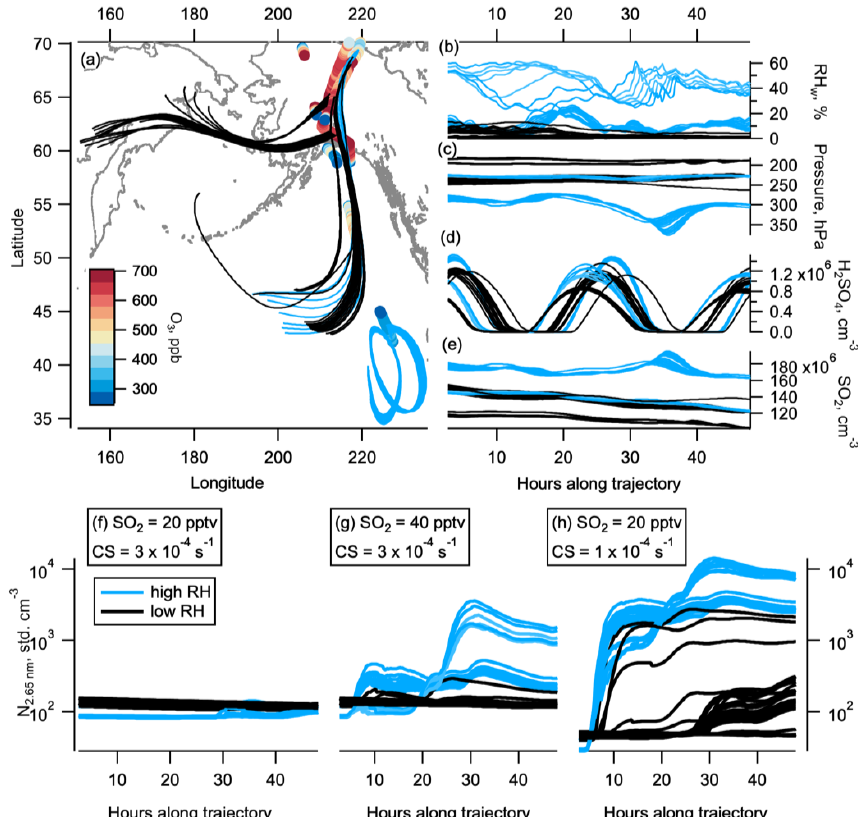
Figure 7. Box modelling and back trajectories. The 48h back trajectories from selected observations in the NH LMS in May. Geographical location of back trajectories (lines) and observations (circles, coloured by ozone level) are shown in panel (a) . Black lines are trajectories where the relative humidity (RH w ) was mostly below 10%, indicating stratospheric conditions. Light blue lines are trajectories where the RH w was often above 10%, indicating tropospheric conditions. RH w , pressure, sulfuric acid, and SO 2 (from initial 20pptv SO 2 ) are shown in panels (b) , (c) , (d) , and (e) respectively. Modelled number concentration of 2.7nm particles on the high-RH w (blue) and low-RH w (black) trajectories are shown for the initial 20pptv SO 2 and starting condensation sink (CS) of 3 × 10 − 4 s − 1 (f) , initial 40pptv SO 2 and starting condensation sink of 3 × 10 − 4 s − 1 (g) , and initial 20pptv SO 2 and starting condensation sink of 1 × 10 − 4 s − 1 (h) . The world map was made with Natural Earth free vector and raster map data, http://www.naturalearthdata.com (last access: 10 December